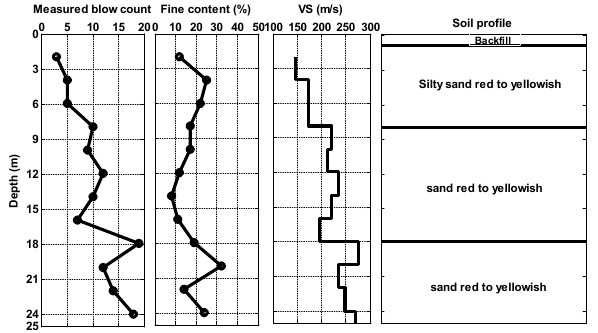
Figure 11: Profile of soil and shear wave velocity according to the depth (petrochemical zone